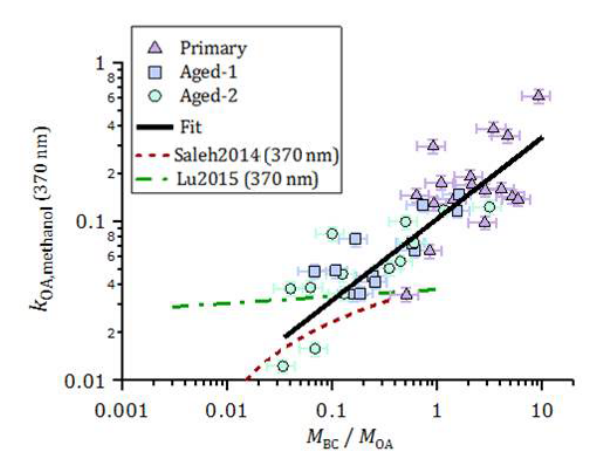
Figure 7. Imaginary part of the OA refractive index at 370nm, obtained from offline UV-visible spectroscopy of methanol OA extracts, plotted as a function of f OA . The data could be em- pirically represented by a linear function in the log–log space, in the measurement range. The ordinary least-squares fit is ( k OA , nm ) = log( M BC /M OA )( 0 . 51 ± 0 . 07 ) + ( − 0 . 98 ± 0 . 05 ) . Also shown are parameterizations of k OA (370nm) for open burning against M BC /M OA estimated based on the online k OA (550nm) measurements in Saleh et al. (2014) and Lu et al. (2015), using the k OA wavelength dependence reported by the respective